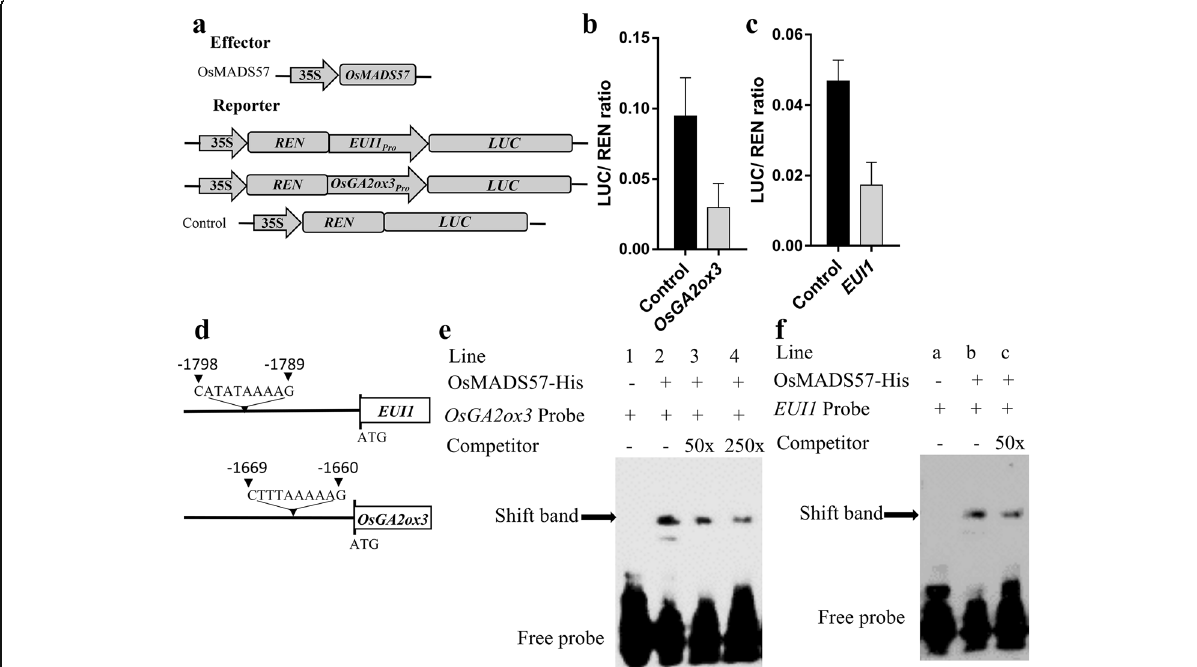
Fig. 5 OsMADS57 directly regulates the expression of OsGA2ox3 and EUI1 by binding to the promoter regions of OsGA2ox3 and EUI1 , respectively. a Schematic diagrams of the effector and reporter constructs used in the dual-luciferase reporter assays. b and c The transient transactivation assay in rice protoplasts. d Schematic diagram of OsGA2ox3 and EUI1 promoter regions showing the CArG-box. e and f EMSA showed that OsMADS57 bound to CArG-box in the promoter regions of OsGA2ox3 ( e ) and EUI1 ( f ). Three independent experiments were conducted with similar results. Data are means± SD ( n =9). Error bars indicate